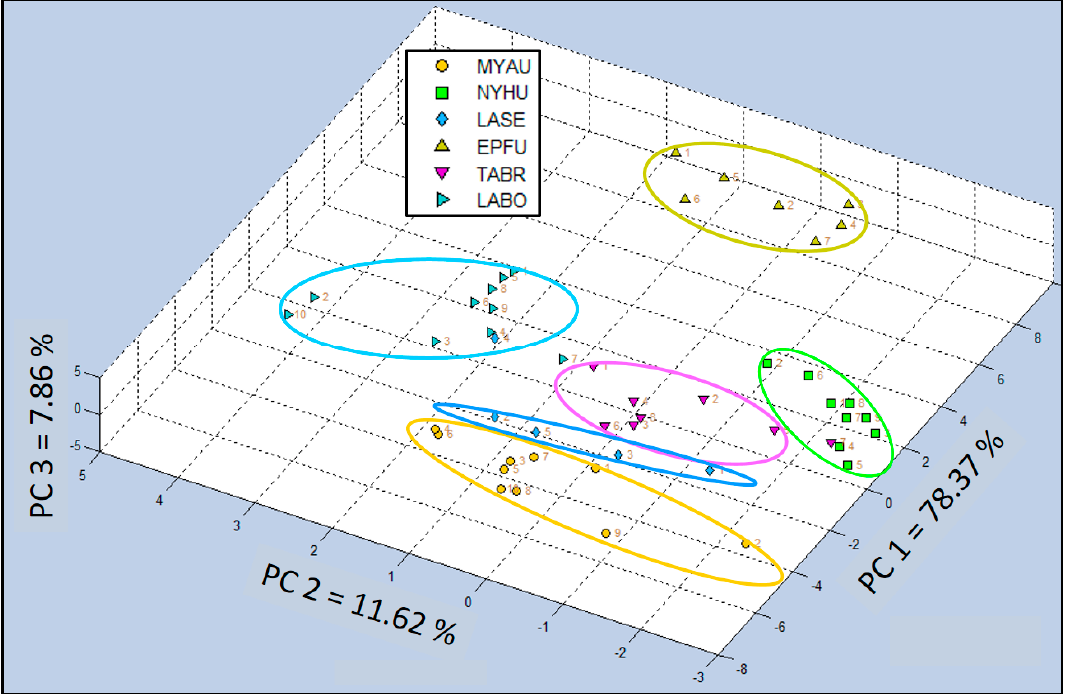
Figure A1. Comparison of C-320 e-nose VOC profiles of bat air samples from six species (Test Group 3) using 3-dimensional Canonical Discriminant Analysis Cross Validation (CDA-CV). Analysis of VOC emissions from Myotis austroripiarus (MYAU), Nycticeius humeralis (NYHU), Lasiurus seminolus (LASE), Eptesicus fuscus (EPFU), Tadarida brasiliensis (TABR), and Lasiurus borealis (LABO).